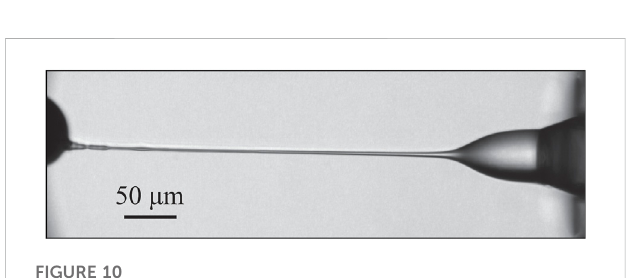
FIGURE 10 Bridging regime. GFR = 0 mg/min, SFR = 2 μ l/min, EP = 6 kV, L = 1.